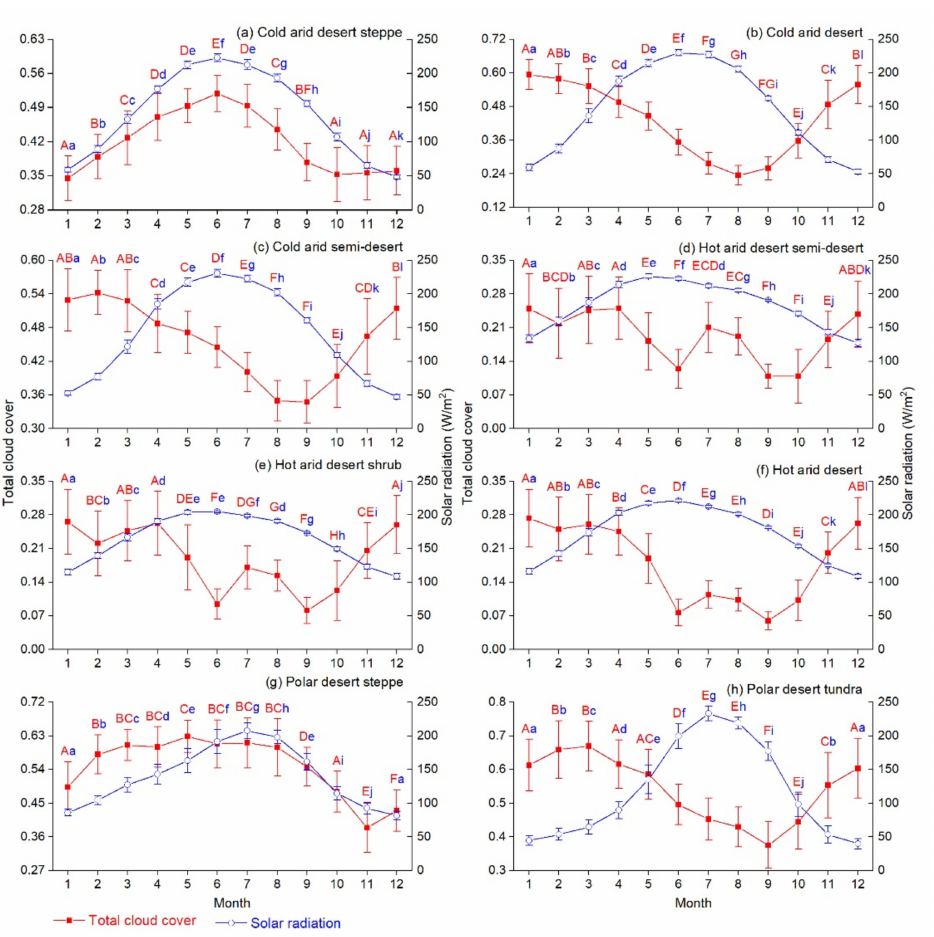
Figure 4. Variation of mean monthly total cloud cover and solar radiation in different desert areas over the Silk Road Economic Belt between 1982 and 2015. Different red uppercase letters indicate significant differences in total cloud cover between different months at p < 0.05, and different blue lowercase letters indicate significant differences in solar radiation between different months at p < 0.05. ( a – h ) indicate different desert areas,